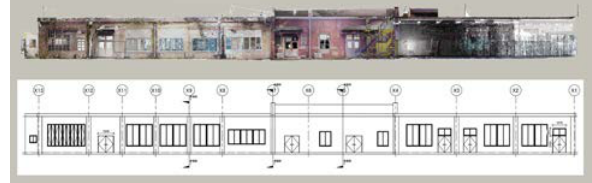
Figure 14: Model assumed on the basis of the cloud of point.